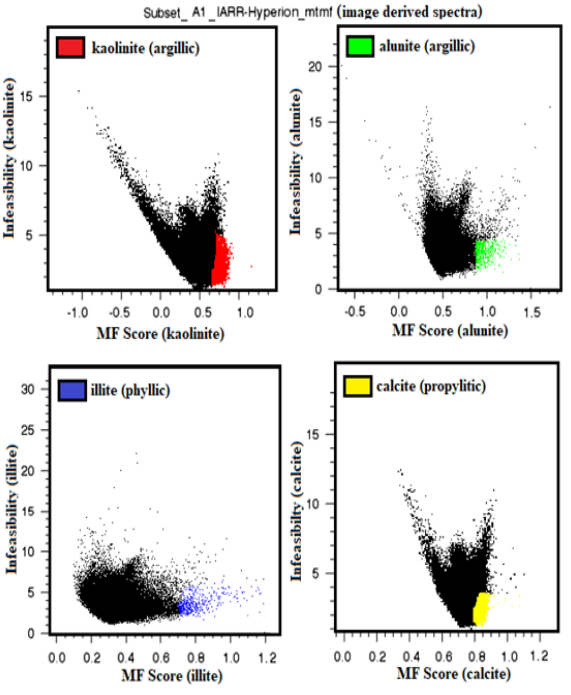
Figure 6: 2-Dimensional scatter plot used to map valid alteration detections at (A) for 4 endmembers in figure